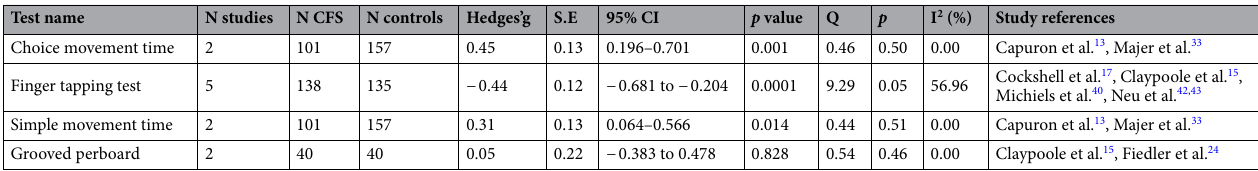
Table 4. Motor functioning: Hedge’s g effect sizes for each test, in descending order. ME/CFS myalgic encephalomyelitis/chronic fatigue syndrome, N